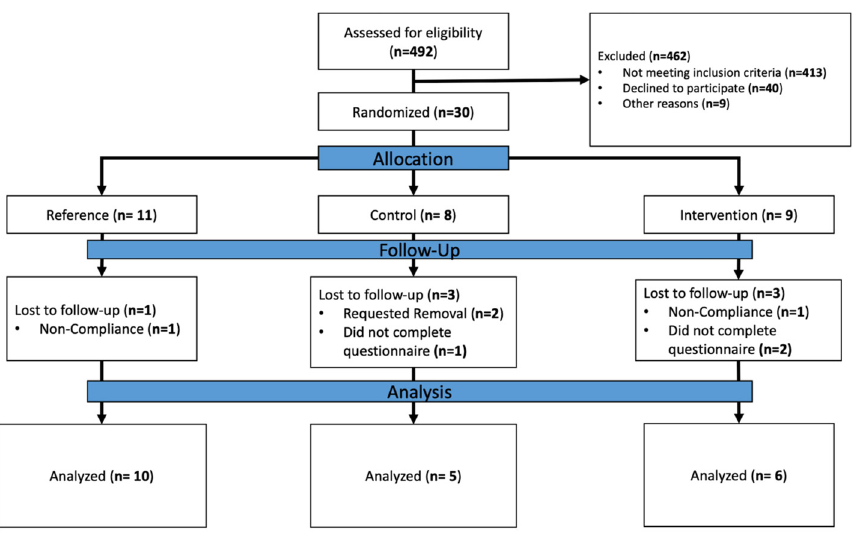
Figure 1. Consolidated Standards of Reporting Trials (CONSORT) diagram for inclusion and exclu- sion of participants.